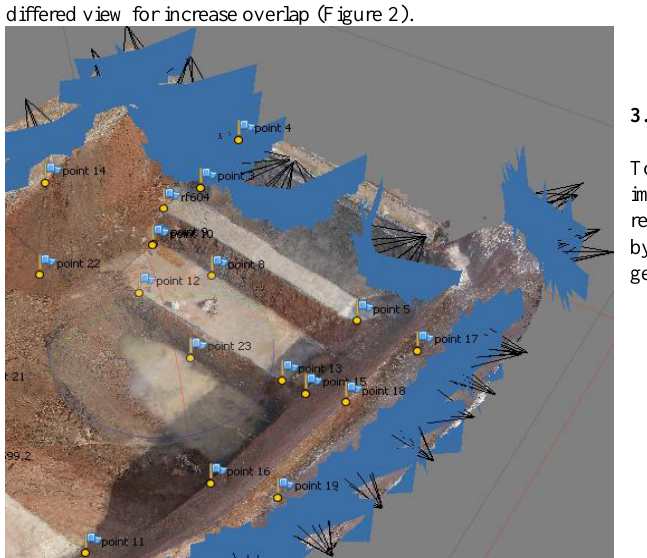
Figure 2. Camera locations and image network